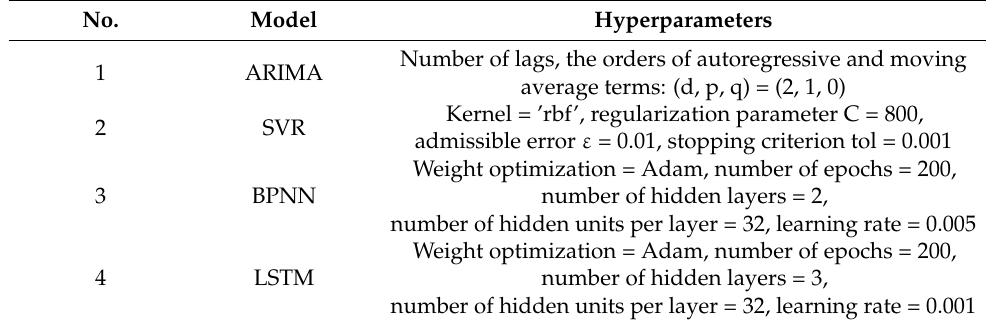
Table 7. Hyperparameters of the benchmark